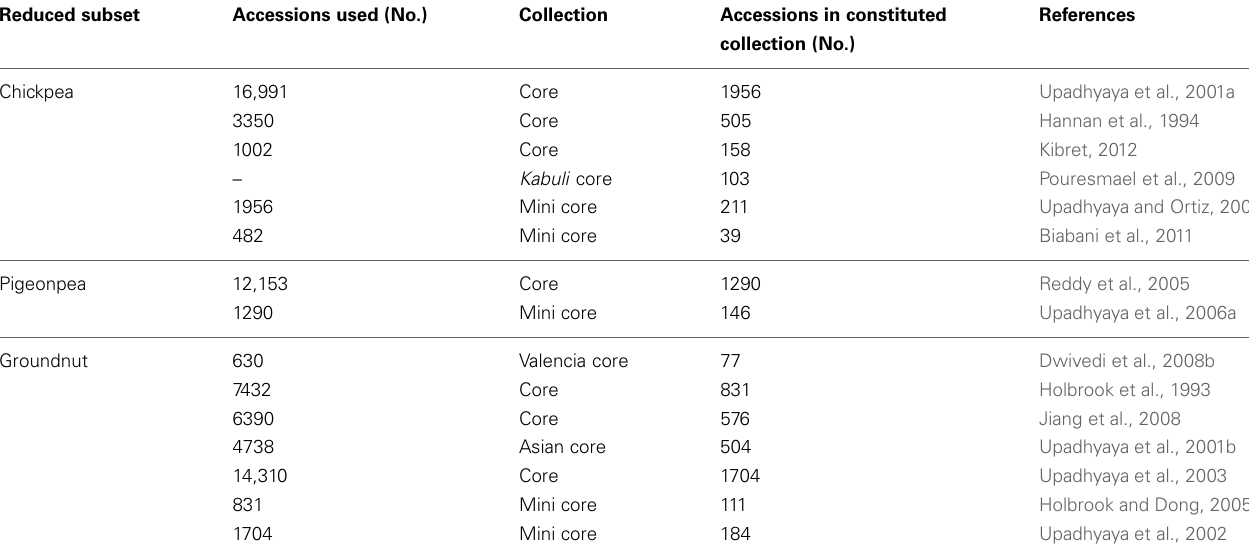
Table 2 | Core and mini core collections as reported in chickpea, pigeonpea and groundnut. Reduced